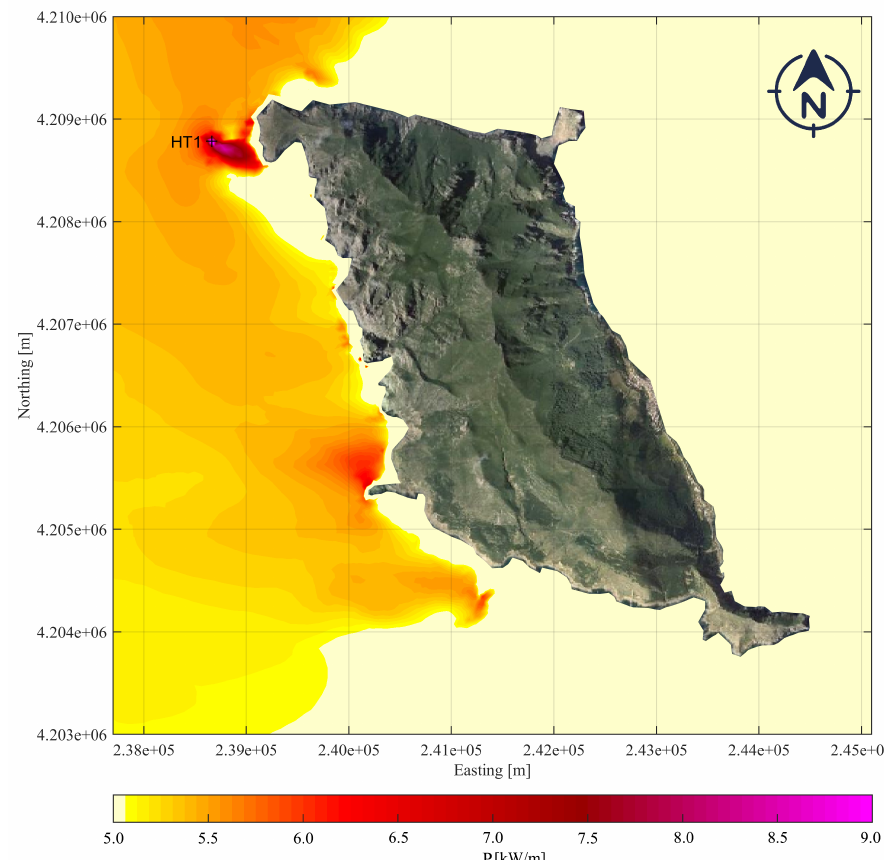
Figure 13. The hotspots near Marettimo in the period between 2009 and 2010. The colour bar shows the mean yearly wave energy flux [kW/m], and the cross represents the hotspot HT1. Table 4. Statistical energy parameters at each hot-spot point; H m 0 the mean significant wave height, flux, P max the maximum wave energy flux and E y the total wave energy in the average year. Point H m 0 [m] STD 0 [m] H m 0, max [m] P [kW/m] P max